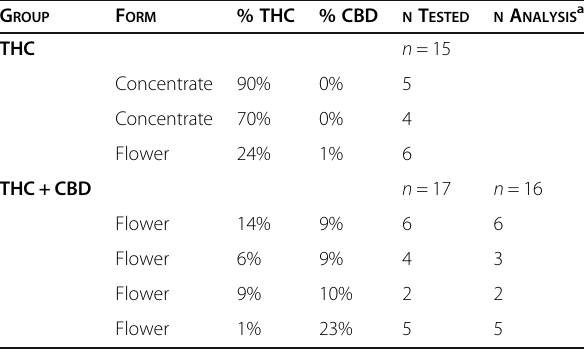
Table 1 Assignment of different products to